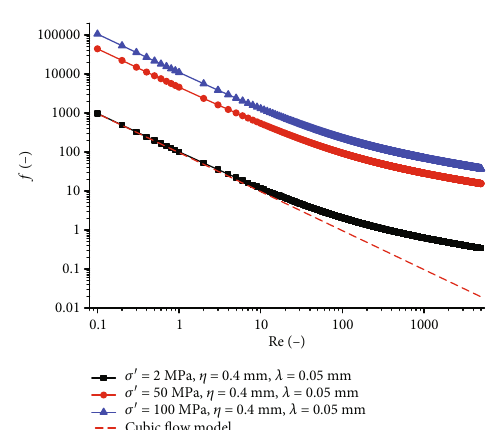
Figure 20: E ff ect of geometry parameters (a) λ and (b) η on the R